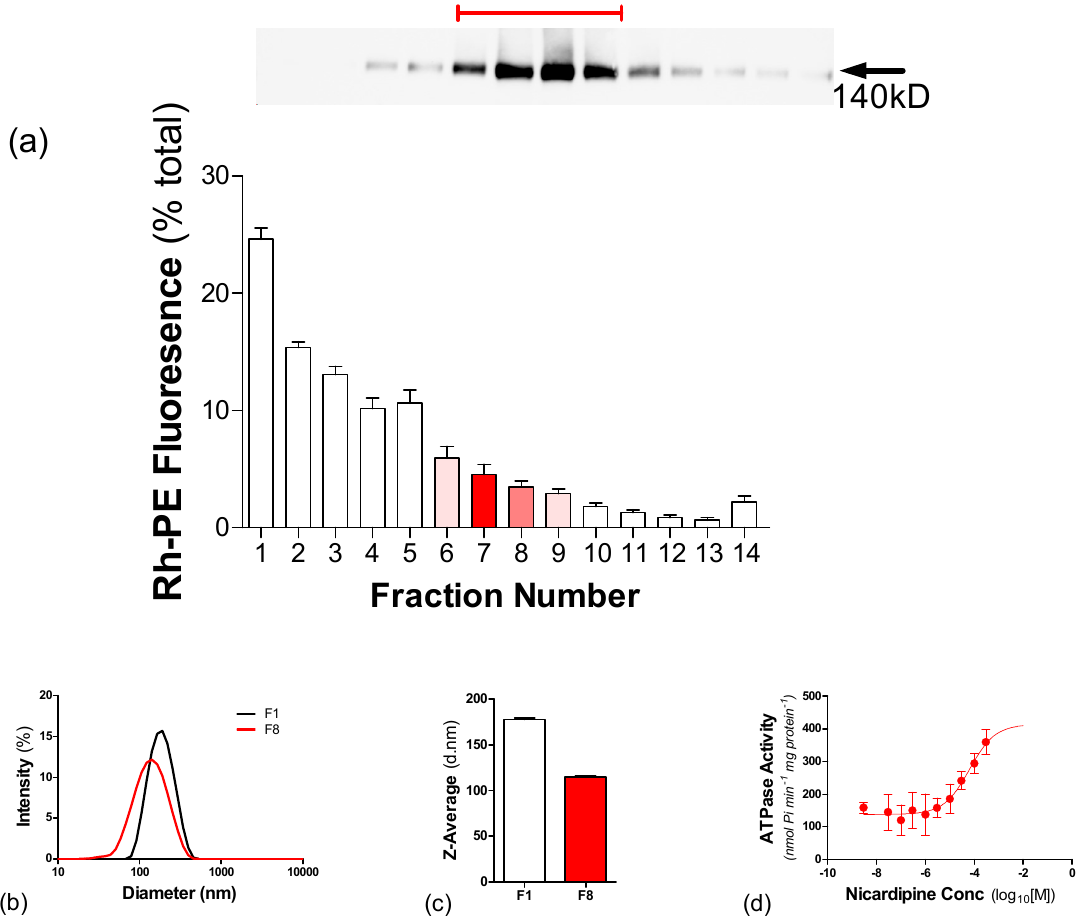
Figure 7. Effectiveness of reconstituting P-gp into hybrid polymersomes. P-gp was reconstituted into hybrid vesicles containing 50 mol% of each of PBd-PEO and EcCL using detergent (DDM) adsorption. The vesicles also contained a small proportion (0.1 mol%) of the lipid probe Rh-PE. ( a ) The presence of Rh-PE fluorescence ( λ ex = 560 ± 5 nm and λ em = 583 ± 5 nm) was monitored in each fraction collected from the sucrose gradient. The presence of P-gp was detected in each fraction of the gradient using Western immune-blotting with an anti-His antibody. The protein fractions ( upper panel ) were placed above their respective position within the sucrose gradient. ( b ) DLS intensity profiles measured for fractions F1 ( top of gradient ) and F8 ( centre of gradient ) obtained from the sucrose density gradient. ( c ) The Z-average of the intensity profiles for F1 and F8, used to estimate the hydrodynamic size of the vesicles. ( d ) The substrate stimulated ATPase activity was measured following reconstitution of P-gp. ATPase activity was measured in the presence of a fixed amount of ATP (2 mM) and at varying concentrations (10 − 9 –10 − 4 M) of Nicardipine. Values represent the mean ± SEM obtained from three independent preparations and data were fitted by non-linear regression of the general dose-response Equation